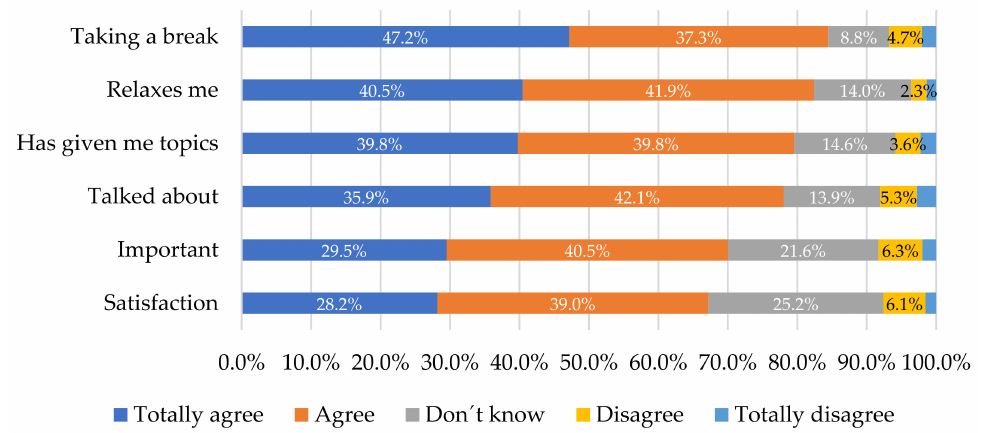
Figure 5. Distribution of percentages of responses to situations of consumption of entertainment